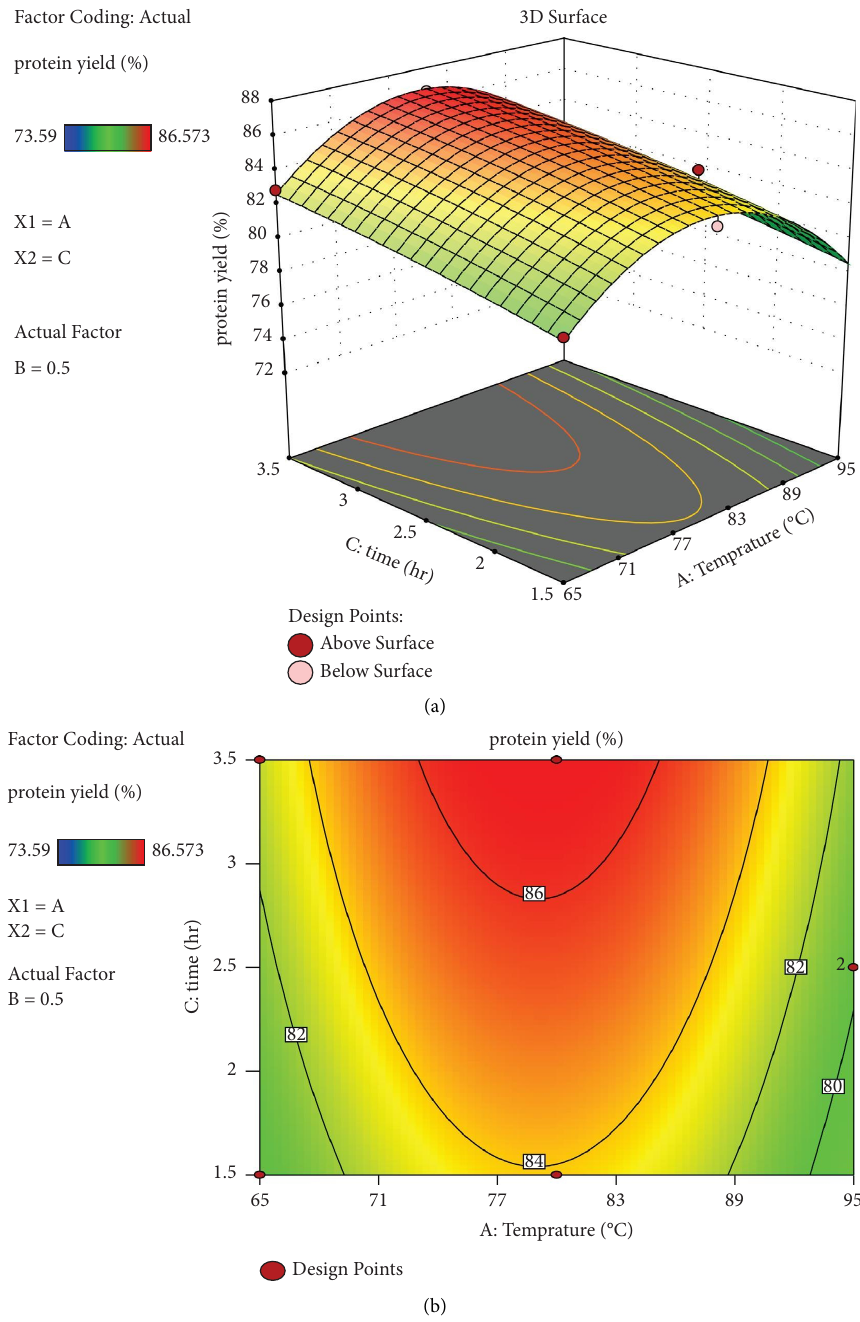
Figure 12: (a) 3D interaction efect temperature and time (b) contour plot interaction efect temperature and